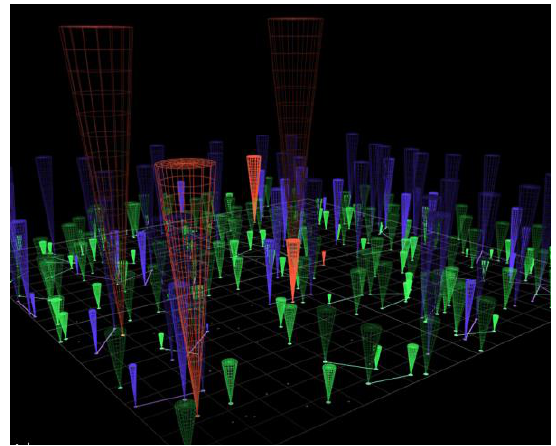
Figure 4. Screenshot of seagrass meadow simulation.